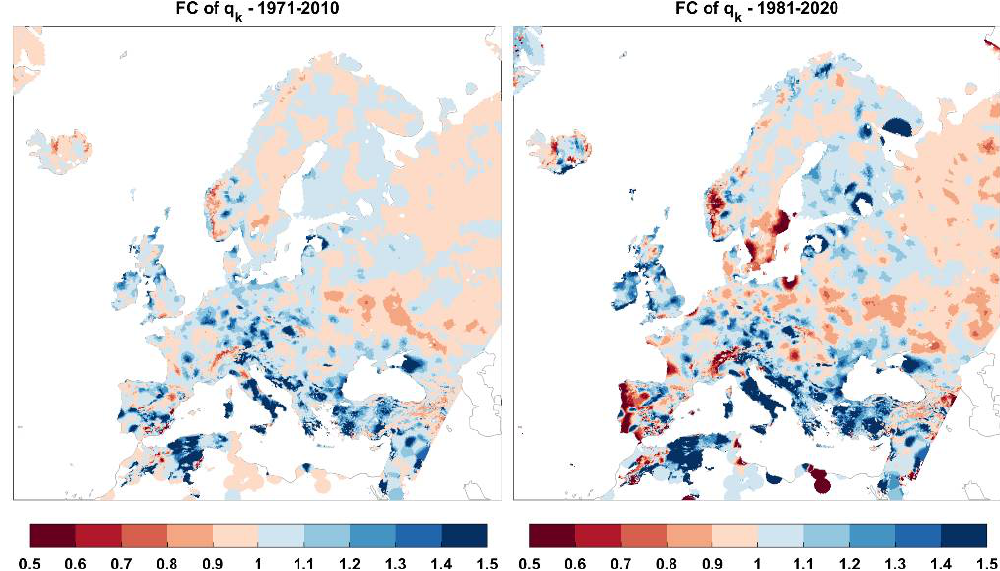
Figure 14. Factors of change maps of characteristic ground snow loads with respect to the 1961–2000 time window based on the UERRA dataset.